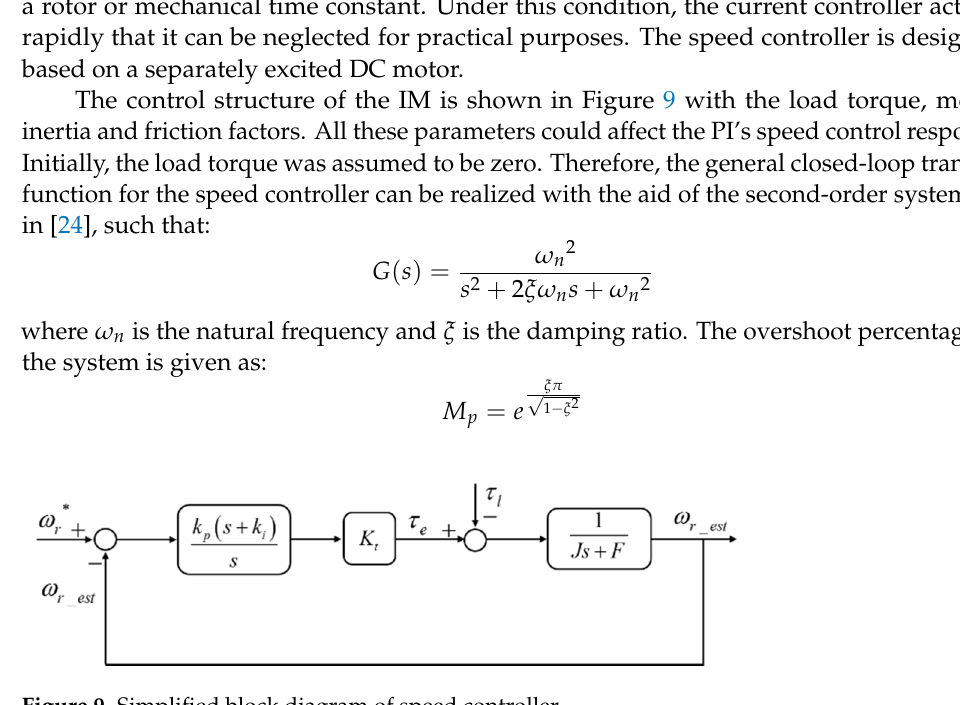
Figure 8. Pole-zero plot of closed-loop transfer function of q –axis current controller.